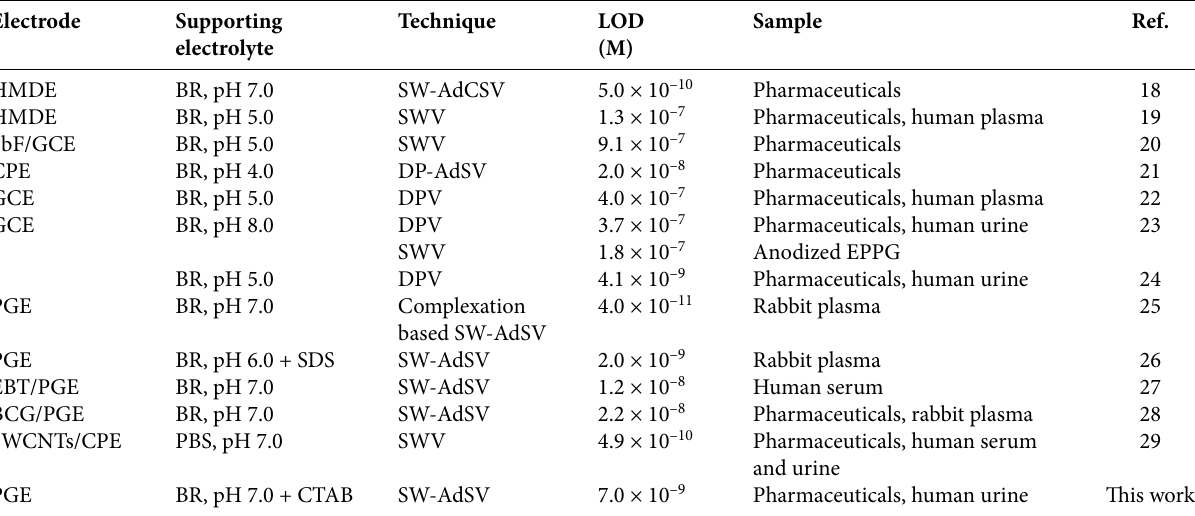
Table 1. Comparison of the analytical performance of PGE for the determination of pantoprazole with literature electrodes. Electrode